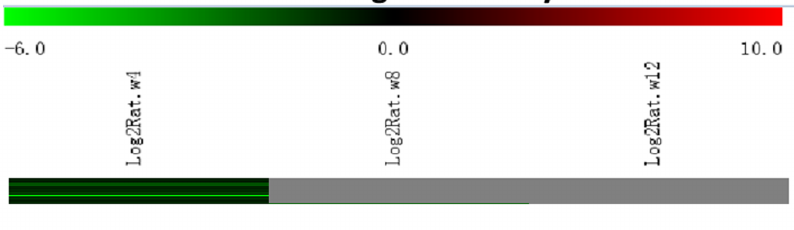
Figure 8. The Heat Map and the list of genes which were down-regulated at the early stage (4 weeks of age). There were a total of 20 genes in the list.